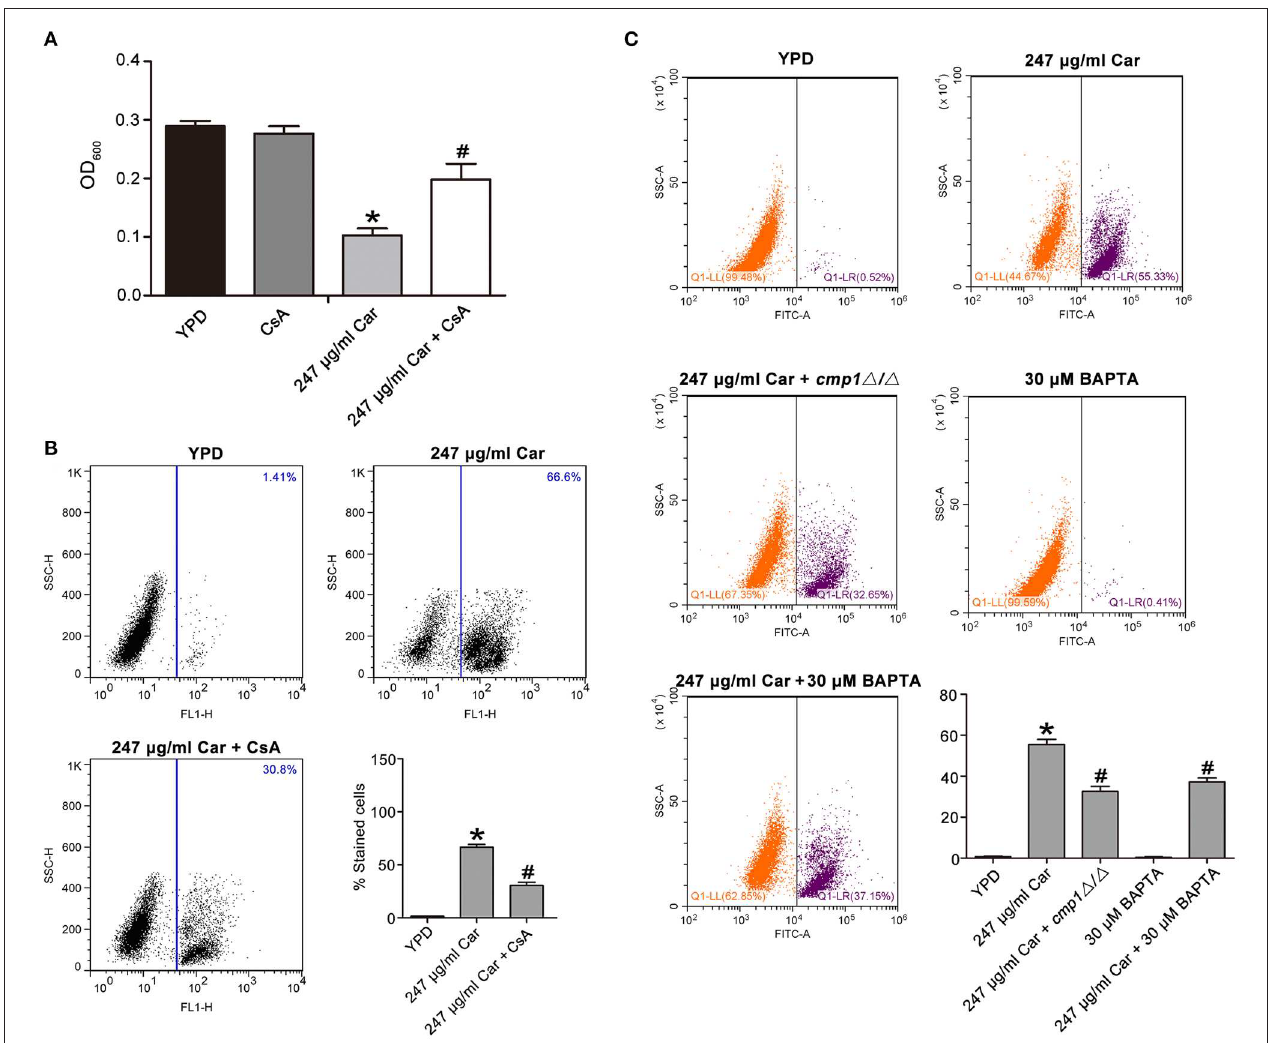
FIGURE 6 | Ca 2 + /calcineruin pathway was involved in carvacrol-induced C. albicans apoptosis. (A) Effects of CsA on carvacrol-treated C. albicans growth were analyzed, and the data was shown as mean ± SD ( n = 5). (B) Metacaspase activation was examined upon pretreated with CsA for 2h. The histogram showed the percentage of stained cells, and the data were exhibited as mean ± SD ( n = 3). (C) The calcineurin mutant cmp1 1 / 1 , and calcium-scavenger BAPTA, were used to observe metacaspase activity. The histogram showed the percentage of stained cells, and the data were expressed as mean ± SD ( n = 3). * P < 0.05 vs. the YPD group; # P < 0.05 vs. 247 µ g/ml Car